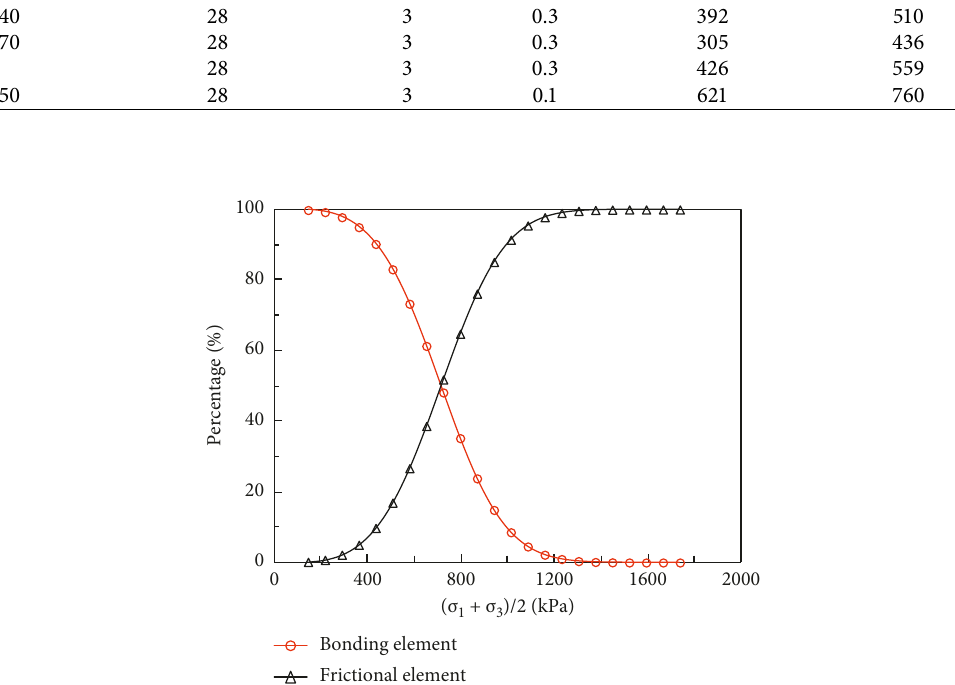
Figure 11: Percentage of cohesion and internal friction versus normal